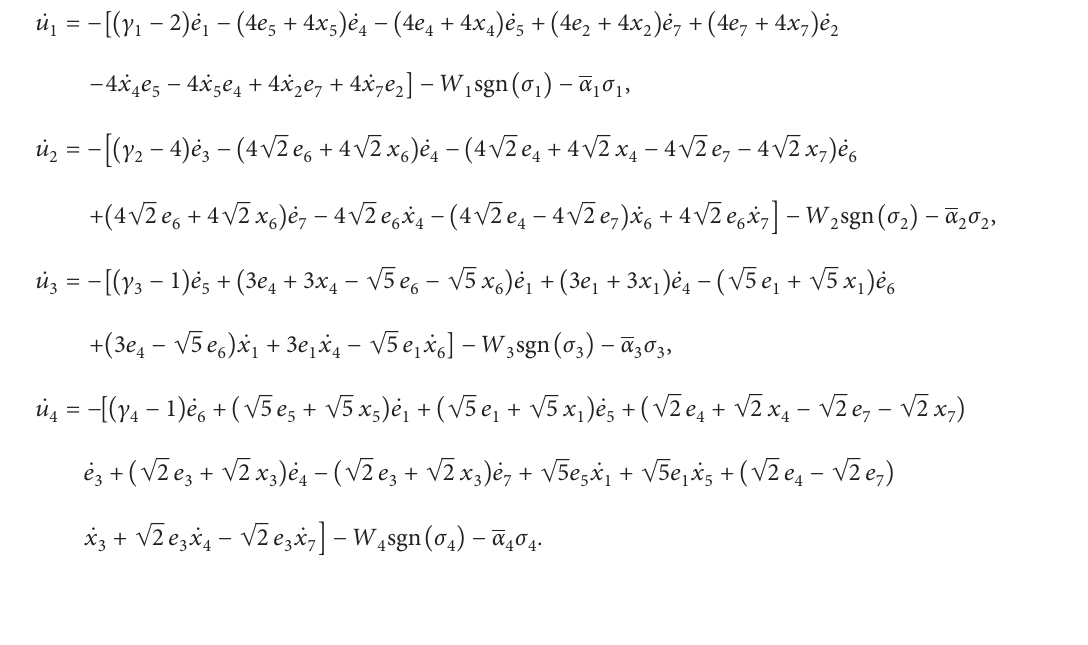
Figure 12: A dynamic sliding mode control of an asymptotically stable orbit at the Reynolds number R symmetrized asymptotically stable state regime at R e � 20 in the master system (7). The controller is switched on at time t � 10. (a) The L ( t ) and y ( t ) versus time. (c) The states x norm of the error e versus time. (b) The states x 1 1 ( t ) versus x ( t ) and y ( t ) showing how the controller drives the states from one attractor to another y 7 1 1